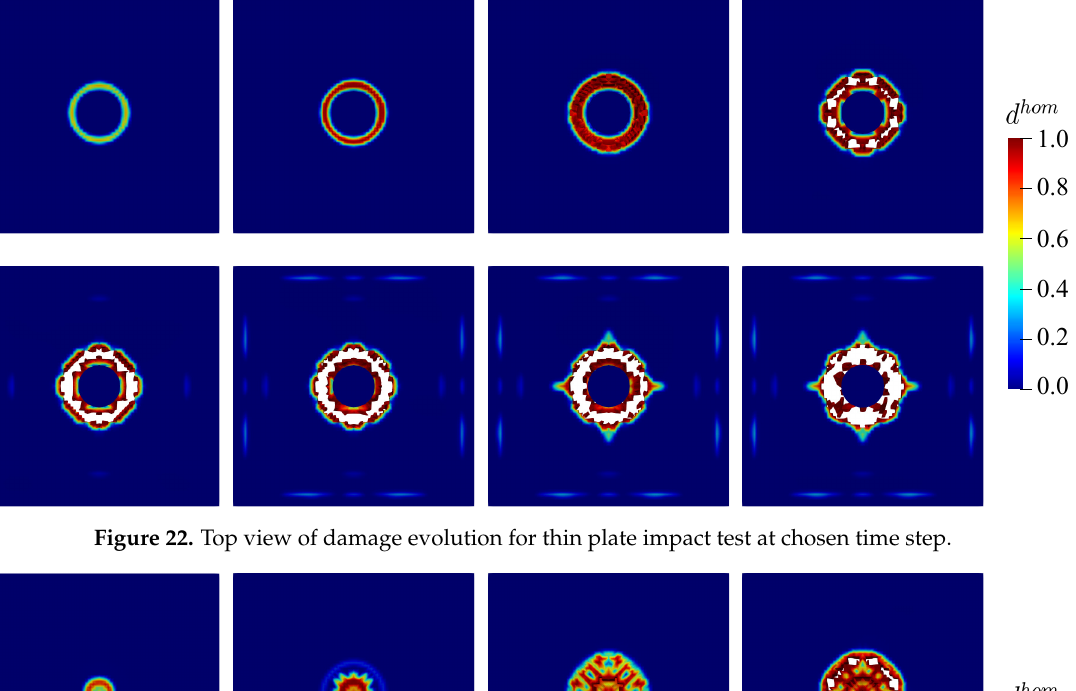
Figure 22. Top view of damage evolution for thin plate impact test at chosen time step.